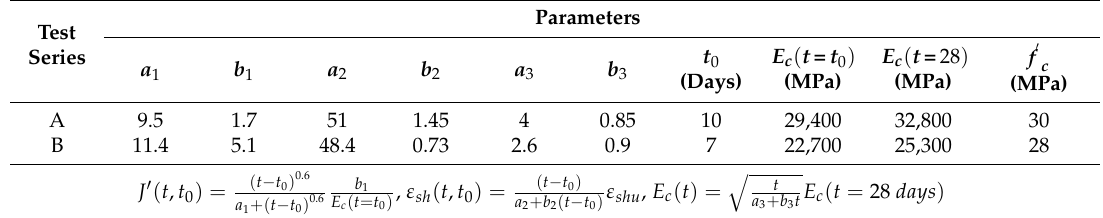
Table 5. Empirical equations for the two test series A and B.